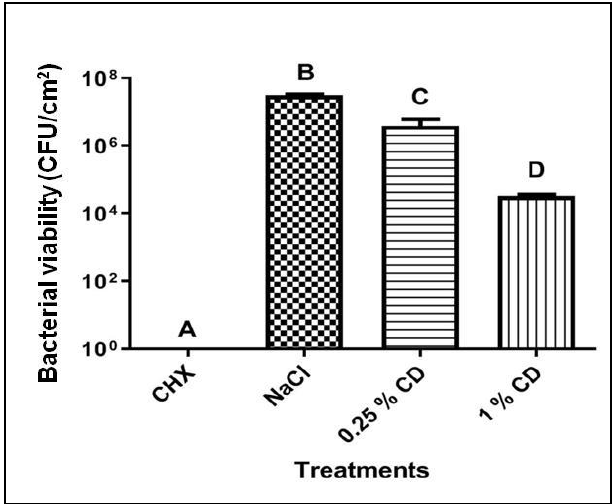
Figure 3. Bacterial viability of S. mutans biofilms treated with chitosan dispersion. CHX: 0.12% chlorhexidine (positive control); NaCl: saline solution (negative control); 0.25% CD: 0.25% chitosan dispersion; 1% CD: 1% chitosan dispersion. Data are expressed as mean ± standard deviation (n = 3). Columns not sharing the same letter (A, B, C, D) are significantly different from each other. ANOVA, Tukey post-hoc test, p < 0.05.